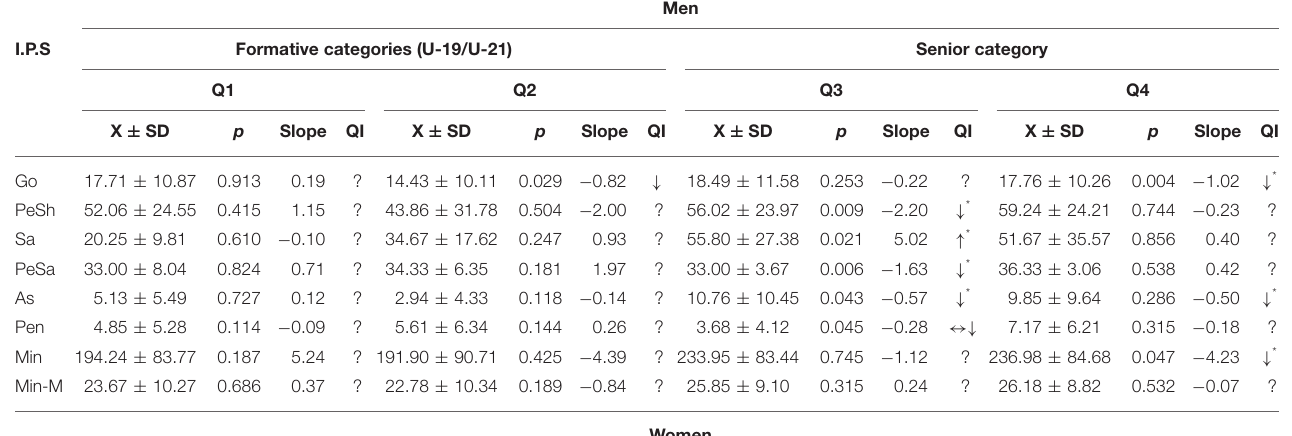
TABLE 5 | Pairwise comparisons between relatively older (Q1) and relatively younger (Q4/Q8) handball players of the individual performance throughout the last 16 seasons (2005–2020) according to gender and competition level.